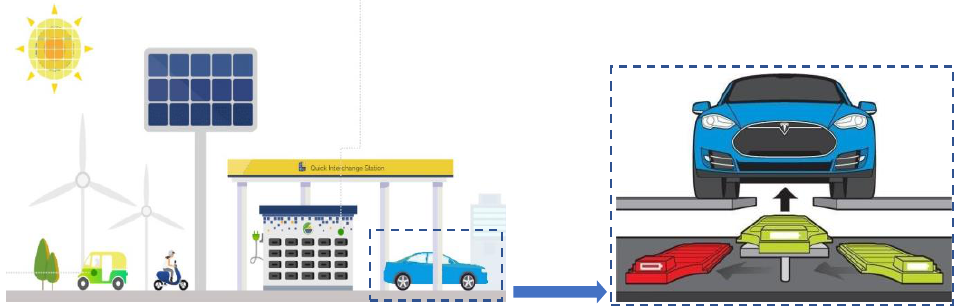
Figure 1. Battery swap automation and refinements on the vehicle (figure source: SUN mobility and Tesla).